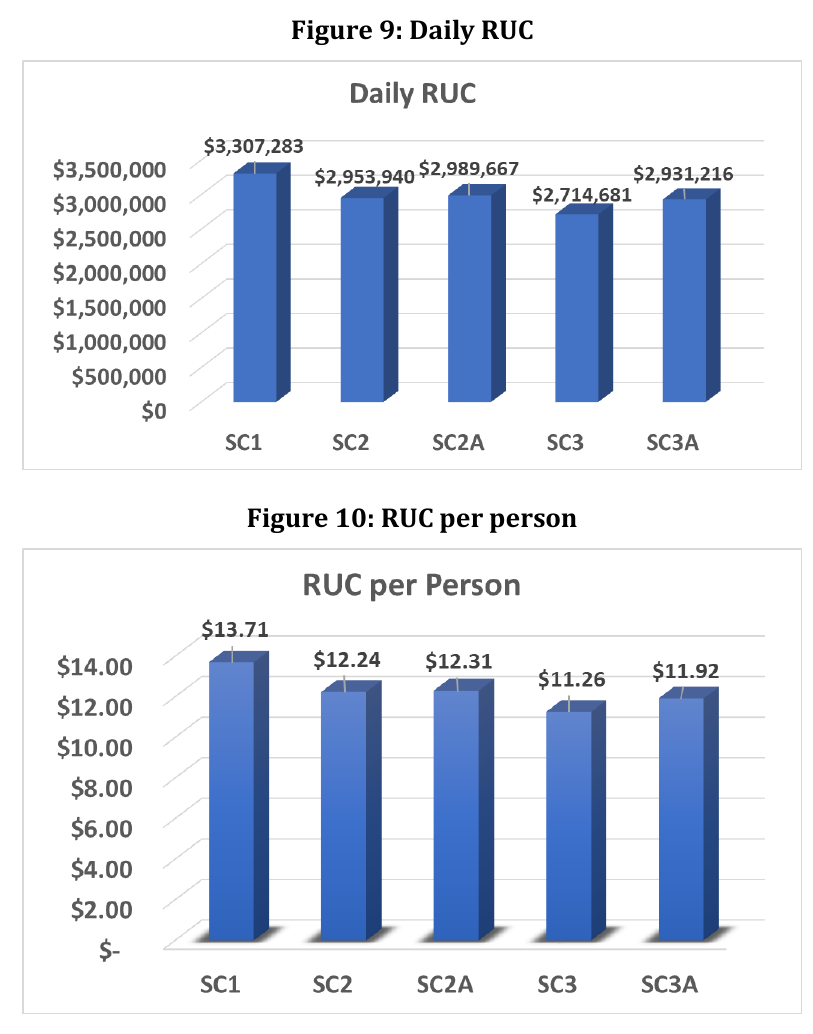
Figure 9: Daily RUC